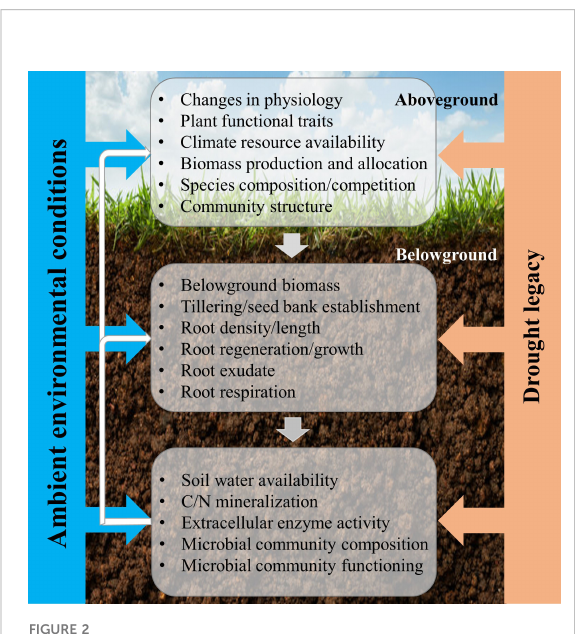
FIGURE 2 Conceptual framework of the responses of aboveground and belowground processes to post-drought for compensatory growth. The three main three components include aboveground plant, root, and soil microorganism, which are determined by plant community trait, soil type and climate (ambient environmental conditions). The effects of drought on the three components are achieved individually, but we hypothesize that the responses of the aboveground plant determine the responses of root after drought, thereby, the microbial community responses, which react on aboveground plant growth, community composition, ultimately, ecosystem stability and function (Williams and De Vries,